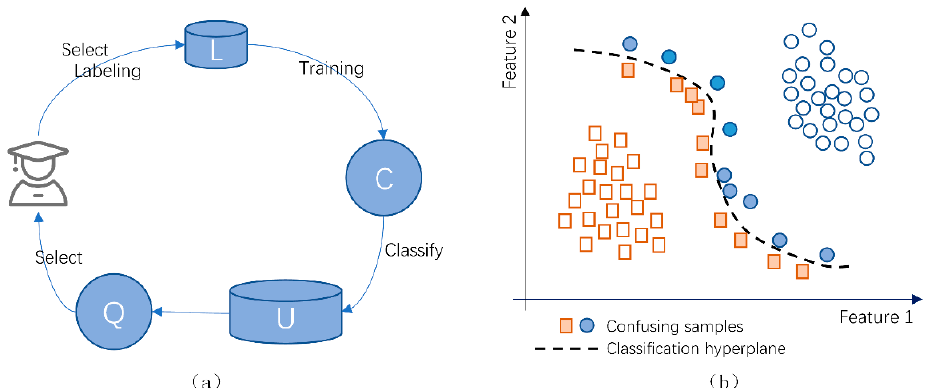
Figure 6. Sample selection by active learning. In subfigure ( a ), L, C, U, and Q represent the labeled sample set, classifier, unlabeled sample set, and query function, respectively. Subfigure ( b ) is a schematic diagram of the distribution of confused samples.